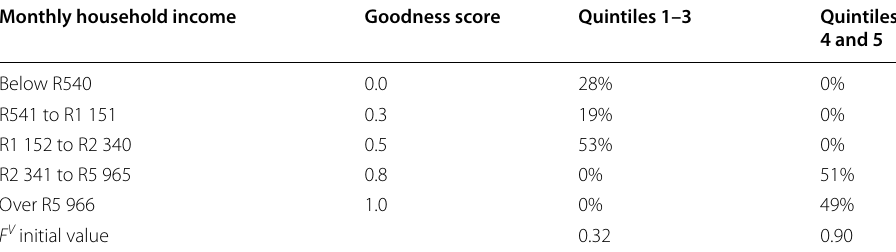
Table 3 Average percentage of children per socio-economic quintile per monthly household income